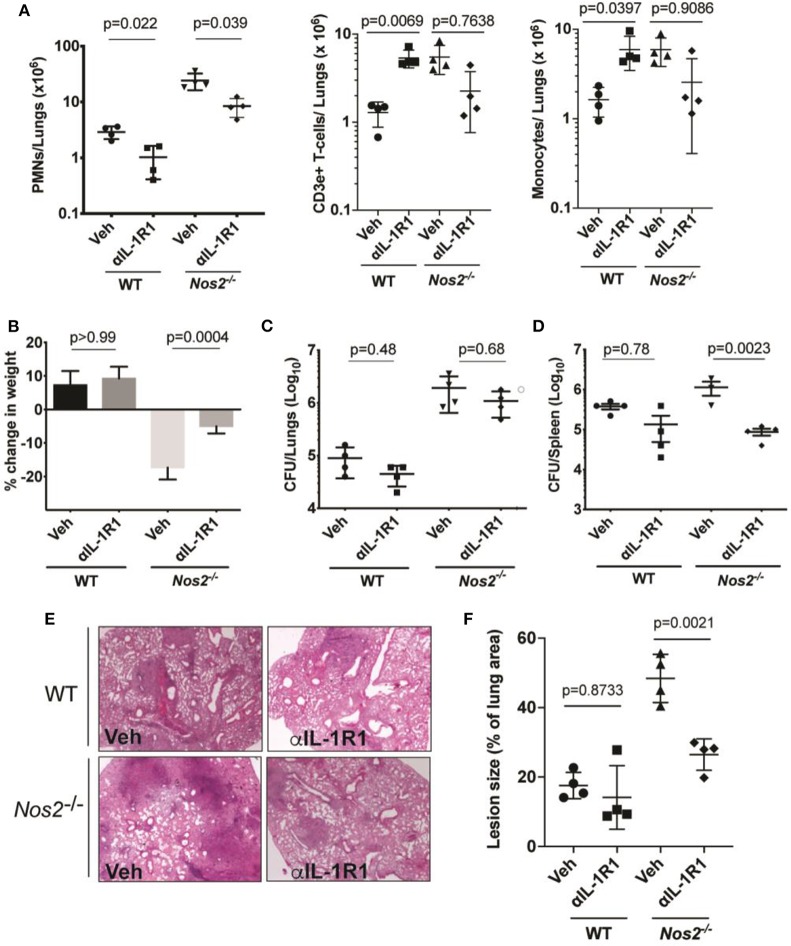
IL-1 inhibition in susceptible mice reduces inflammation with no effect on lung bacterial burden. Wild type C57BL/6 and Nos2−/− mice were infected with Mtb Erdman for 2 weeks and treated with anti-IL-1R1 (αIL-1R1) for the subsequent 2 weeks. (A) Lung neutrophil/PMN (CD45+ CD11b+ Ly-6C− CD3e−Ly-6G+), T-cell (CD45+ Ly6C−LyG−CD3e+), and Monocyte/macrophage (CD45+ CD11b+ Ly-6G− CD3e− Ly6C+) recruitment to the lung among different treatment groups were quantified by flow cytometry. (B) Weight loss and (C) CFU in lung and (D) spleen are shown. Data shown (mean ± SD) are representative of two independent experiments. One-way ANOVA with Sidak's multiple comparisons-test was used. N = 4 mice per treatment cohorts. (E) Histopathology analysis of a single lung lobe from WT or Nos2−/− mice was performed by Hematoxylin-eosin (H&E) staining and (F) Lesion size was quantified by analyzing the histopathological images from each mouse lung among treatment groups (n = 4). Data shown are expressed as Mean ± SD. One-way ANOVA with Tukey's multiple comparison test was applied to calculate the p-value.